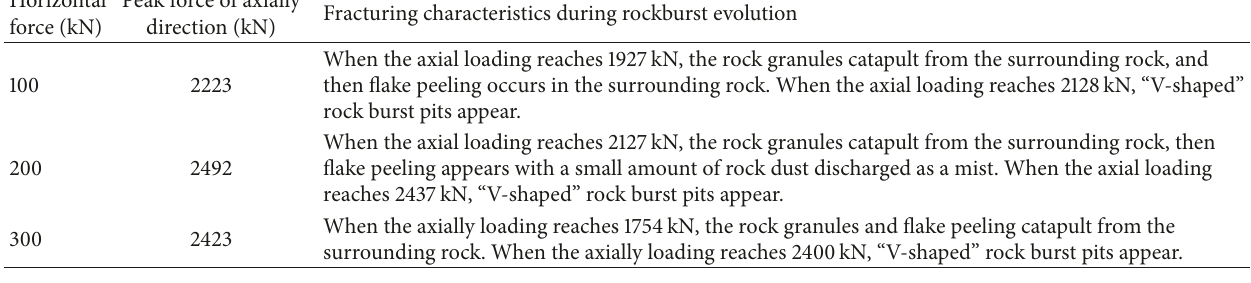
Table 2: Experimental results of a rockburst in tunnel.